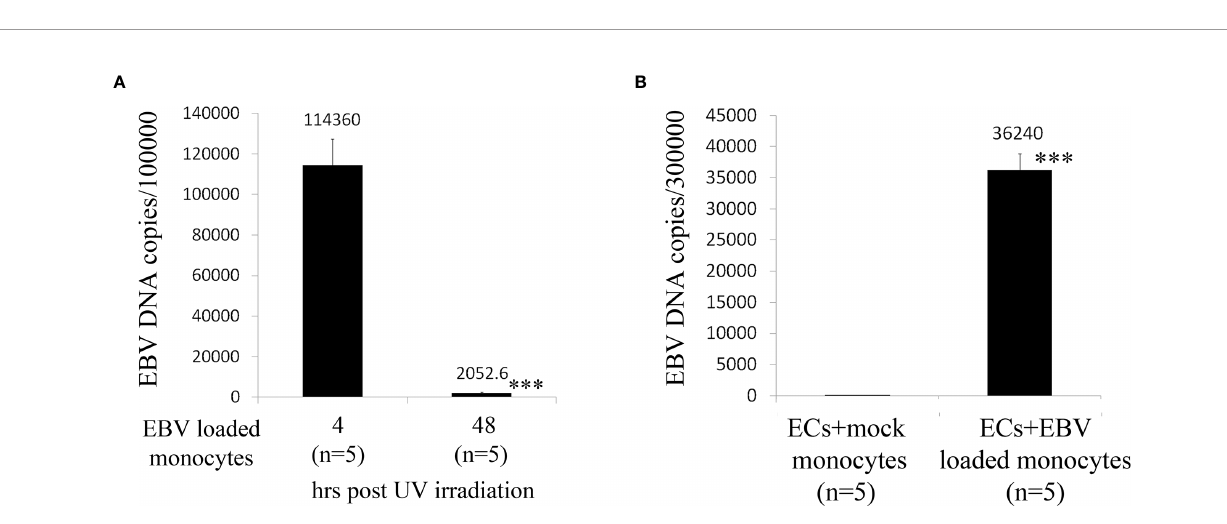
FIGURE 4 | Assay for virus genomic copies in monocytes and endothelial cells. (A) Irradiated monocytes were exposed to EBV preparations at known concentration (EBV/p2089 loaded monocytes) or re-suspended in medium without virus preparation (mock loaded monocytes). (B) EBV/p2089 loaded monocytes and mock loaded monocytes were co-cultured with human dermal microvascular endothelial cells (HDMECs) grown on collagen-coated chamber slides. After co- culture for up to 48 hrs post infection (PI), cells were harvested and processed for DNA assay. (A, B) Virus DNA copies per exposed cells were quanti fi ed by qPCR amplifying within the BALF5 gene and measured using SYBR Green chemistry. Shown here are copies of viral DNA calculated by standard curve. All the samples were tested in triplicates. The average of copies number is represented by horizontal line ± SE. p-values calculated using Student T-Test 2 tails.